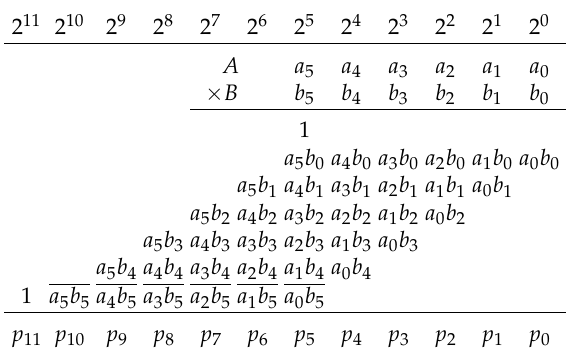
Figure 3. Proposed ( m × n )-bit constant-coefficient multiplier (KCM), where m = n = 6, A is a positive constant and B is a signed